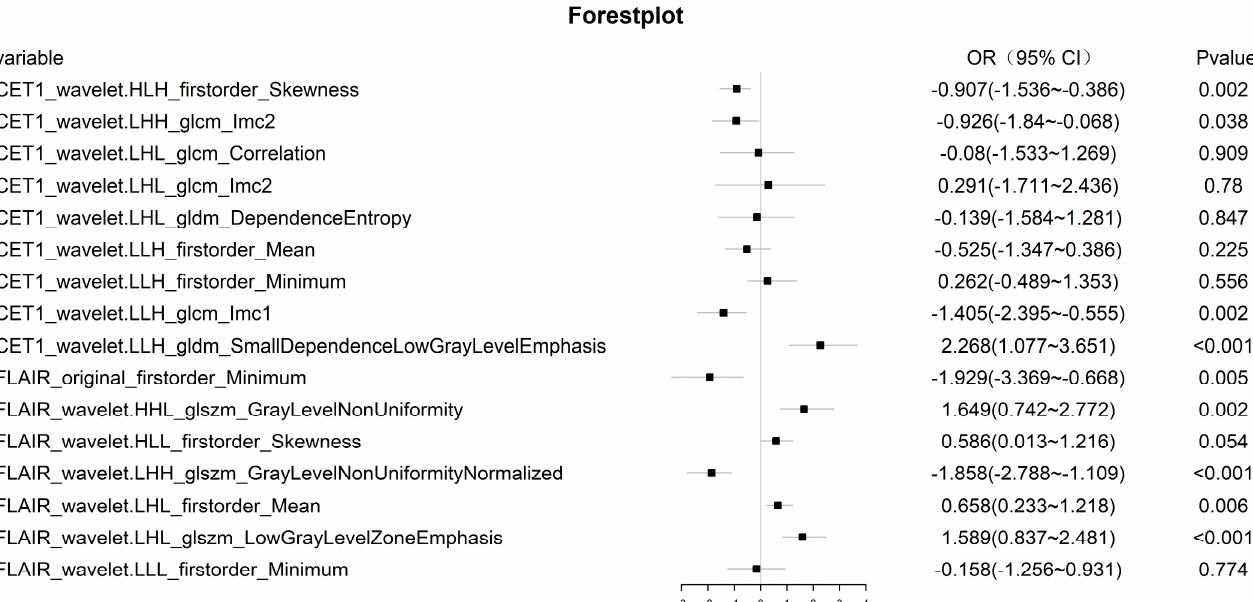
Figure 4. Sixteen features of the radiomic model, and the OR values of each radiomic feature and its 95% CI and p value.